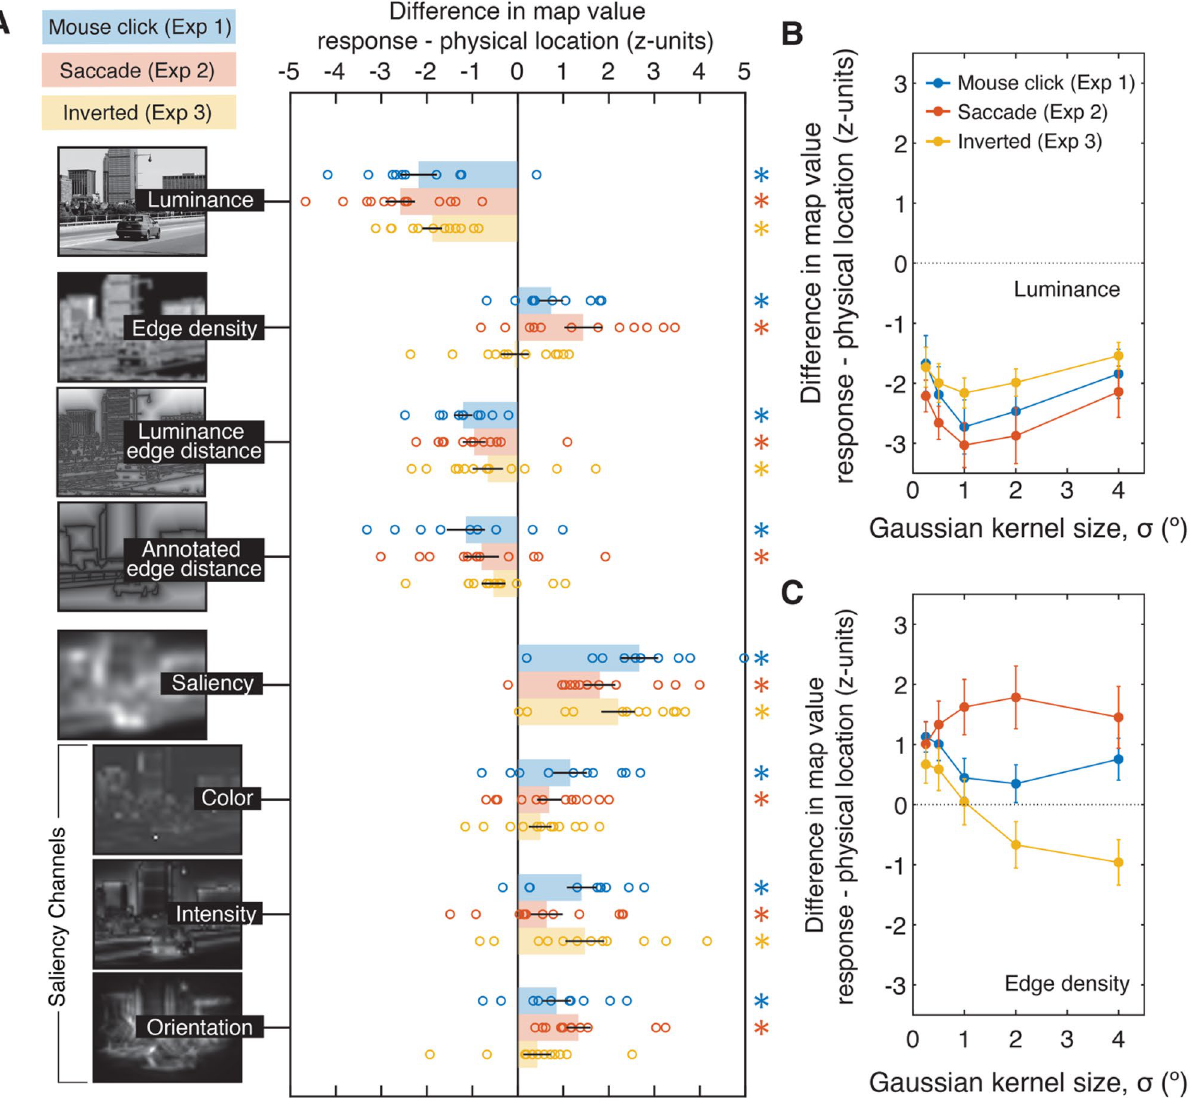
Figure 2. ( A ) Influence of image features on the direction of localization errors within natural images. Bars indicate the mean difference score for each image statistic (examples shown in the left column) in each experiment (Experiments 1, 2, and 3 shown blue, red, and yellow, respectively), with scatter points representing individual observers (see text for description of the direction of each effect). To facilitate comparison across the different measures, all values are expressed as the z-score of the observed mean difference score relative to the null distribution produced by the permutation procedure illustrated in Fig. 1B. Asterisks on the right side of the figure panel indicate significant differences from 0 based on individual permutation tests adjusted for a false discovery rate of 0.05 using the Benjamini–Hochberg procedure (see Supplemental Fig. S3B for histograms of the group null distributions). ( B ) Difference scores (in z-score units) for luminance, analyzed separately for each Gaussian kernel size (standard deviation, σ). ( C ) Difference scores for edge density at each kernel size. Error bars in each panel represent ± 1 standard error of the mean